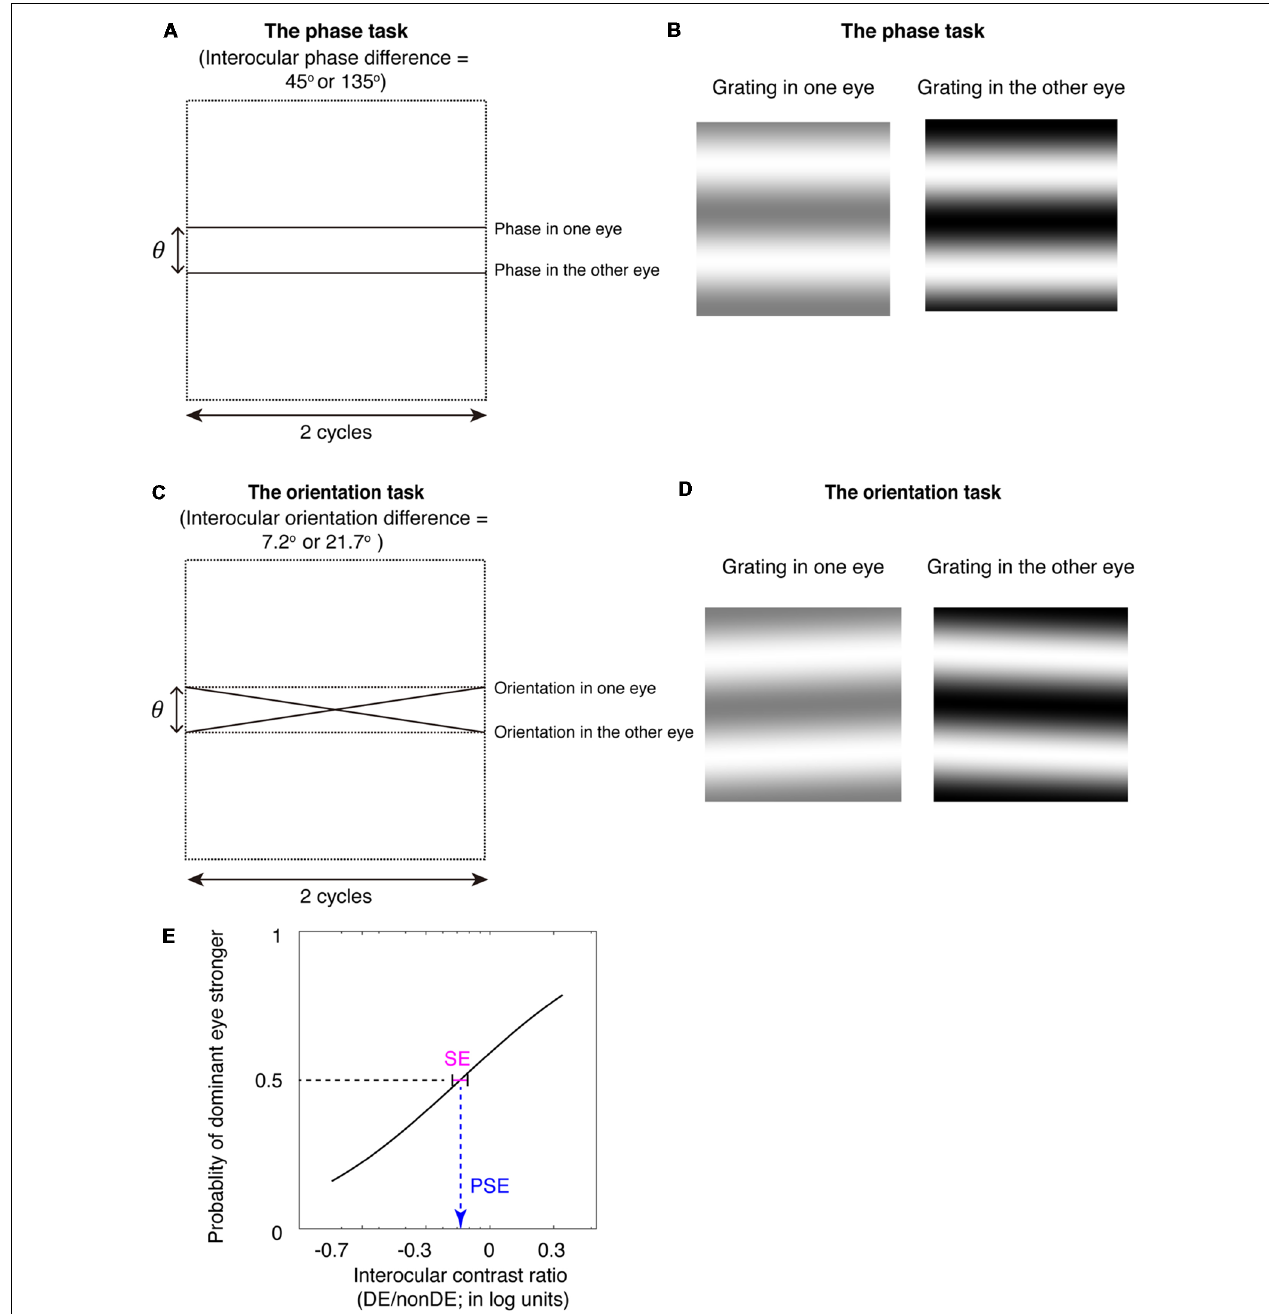
FIGURE 1 | The binocular phase and orientation combination tasks. (A) Diagrammatic illustration of the binocular phase combination task. In Experiments 1 and 3, the interocular phase-shift difference was set as 45 ◦ ; In Experiment 2, the interocular phase-shift difference was set as 135 ◦ . (B) The two horizontal gratings that we dichoptically presented to the two eyes in the binocular phase combination task. The contrast of the gratings in the nondominant eye was fixed at 50%, while the contrast of the gratings in the dominant eye was varied with an interocular contrast ratio (0.2, 0.5, 0.8, 1.1, 1.4, 1.7, and 2.0); subjects were instructed to answer whether the dark stripe of the perceived cyclopean grating was above or below the center of the screen by pressing a keyboard. (C) Diagrammatic illustration of the binocular orientation combination task. In Experiments 1 and 3, the interocular orientation difference was set as 7.2 ◦ ; which enabled a 45 ◦ of interocular phase difference at the edge of the two-cycle gratings; In Experiment 2, the interocular orientation difference was set as 21.7 ◦ ; which enabled a 135 ◦ of interocular phase difference at the edge of the two-cycle gratings. (D) The two oriented gratings that we dichoptically presented to the two eyes in the binocular orientation combination task. The contrast of the gratings in the nondominant eye was fixed at 50%, while the contrast of the gratings in the dominant eye was varied with an interocular contrast ratio (0.2, 0.5, 0.8, 1.1, 1.4, 1.7, and 2.0); subjects were instructed to answer whether the perceived cyclopean grating was rotated